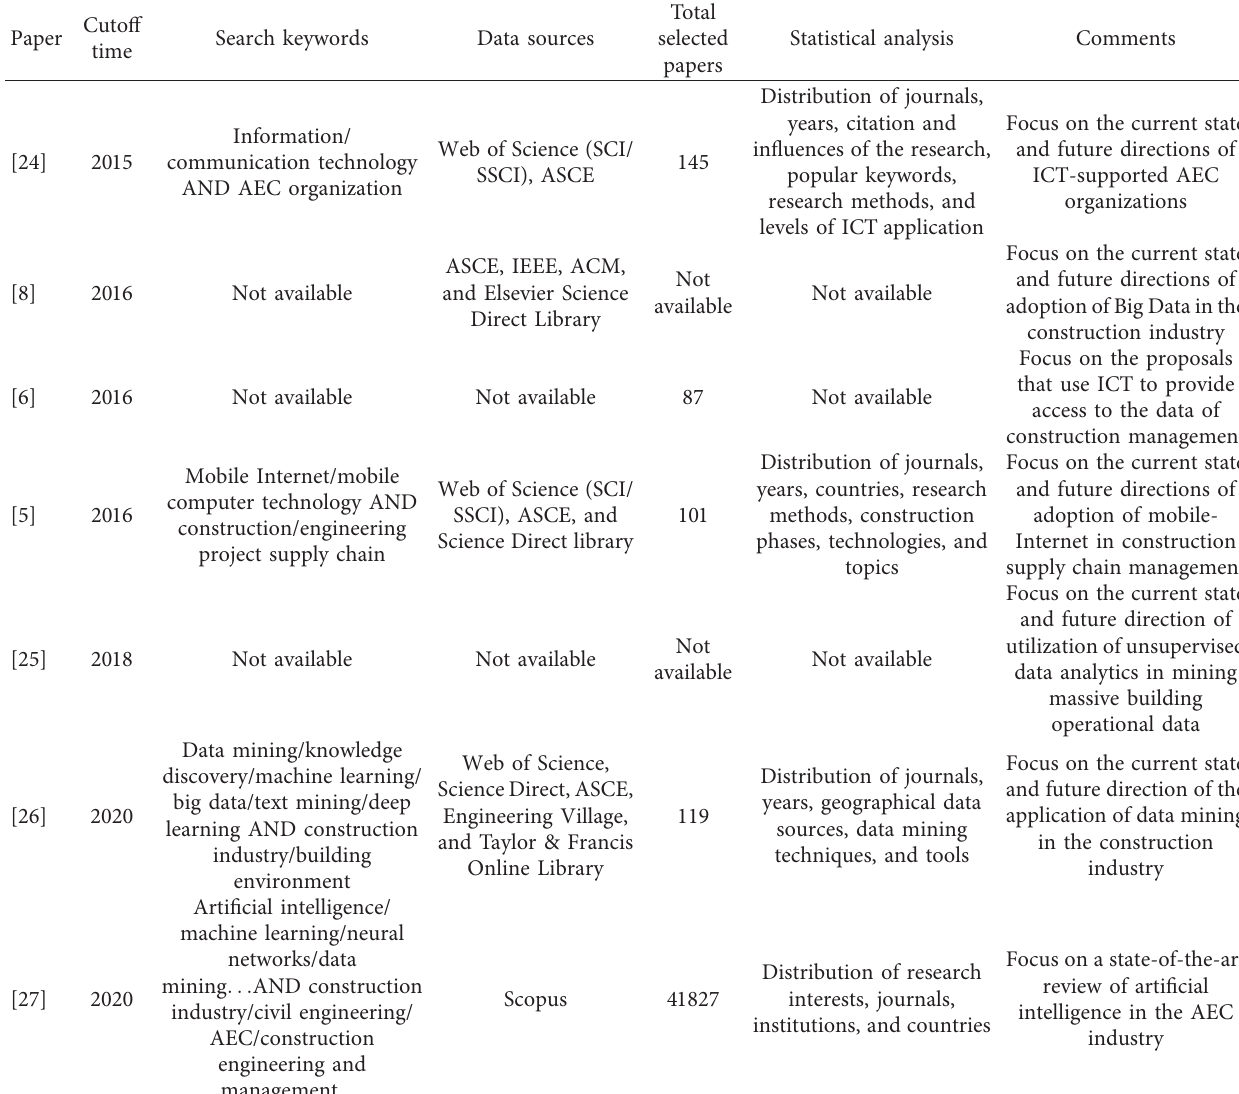
Table 1: Related work on literature review for digital construction. Cutoff Search Paper time